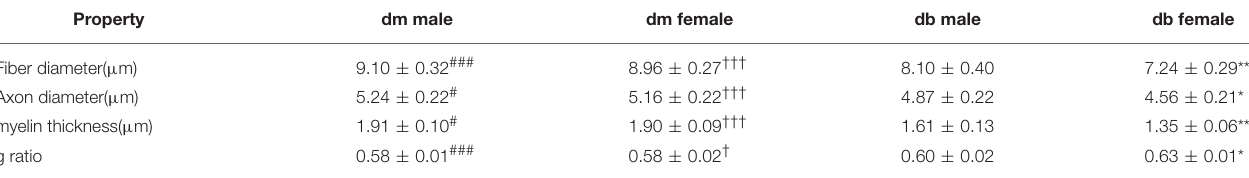
TABLE 2 | The quantitative data of histomorphometric parameters of sciatic nerves.